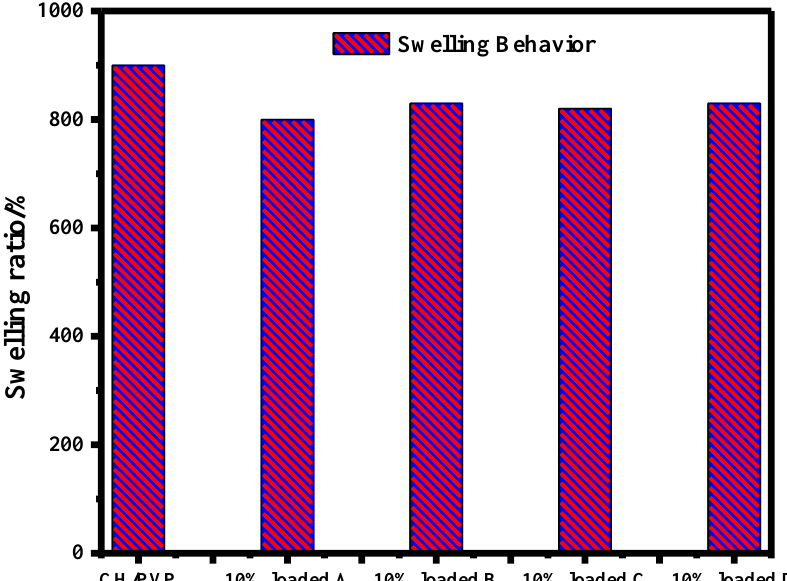
Figure 3. Swelling behavior of electrospun CH/PVP nanofibers loaded with 10% 3β -cloro- 5α -cho- lestano- 2′ -methyl-2- oxazoline (A), 3β -acetoxy- 5α cholestano - 2′ -methyl-2-oxazoline (B), 3β -chloro- N-amido- 5α -cholestano- aziridine (C) and 3β -acetoxy-N-amido- 5α -cholestano-aziridine (D).